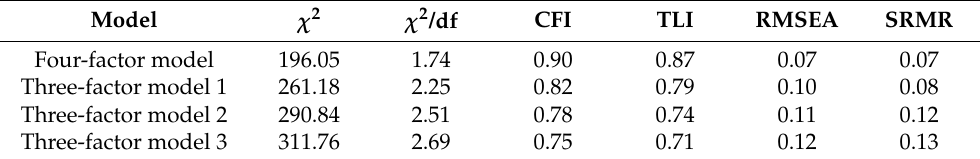
Table 2. Confirmatory factor analysis results.